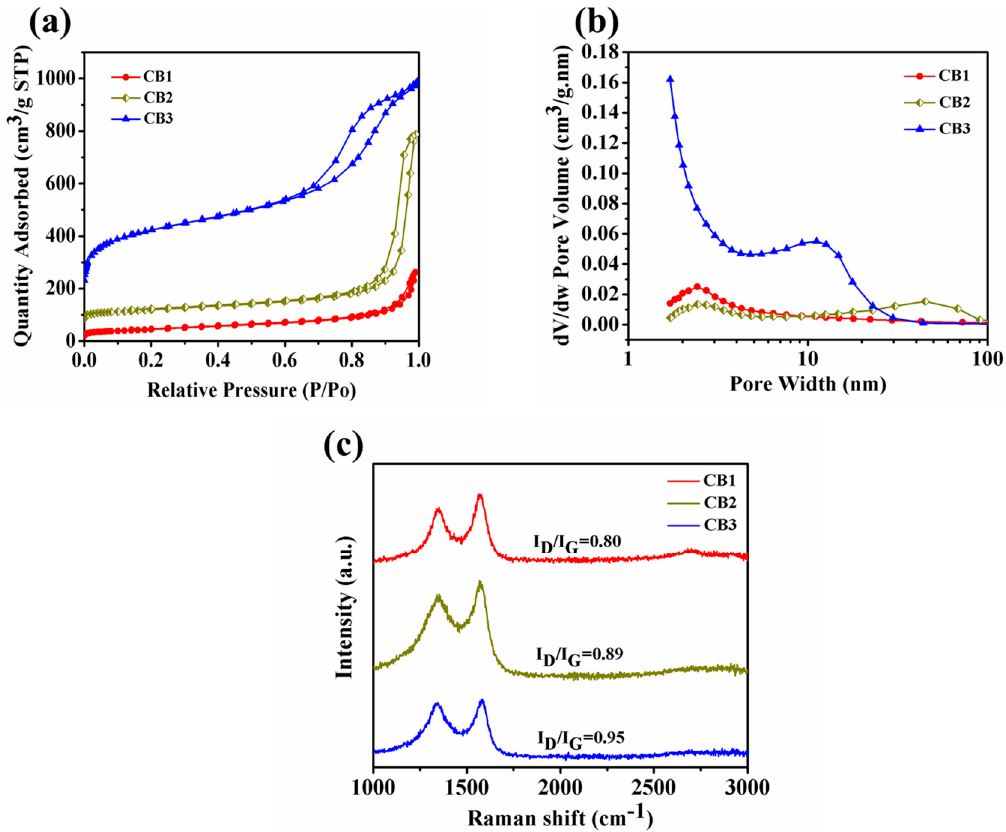
Figure 2. ( a ) Nitrogen adsorption/desorption isotherms at standard temperature and pressure (STP), ( b ) Barrett-Joyner-Halenda (BJH) model pore size distribution, dV/dw refers to the change rate of pore volume with pore size. ( c ) Raman spectra of carbon black 1 (CB1), CB2 and CB3, I D /I G is the ratio of the intensity of D peak to that of G peak.